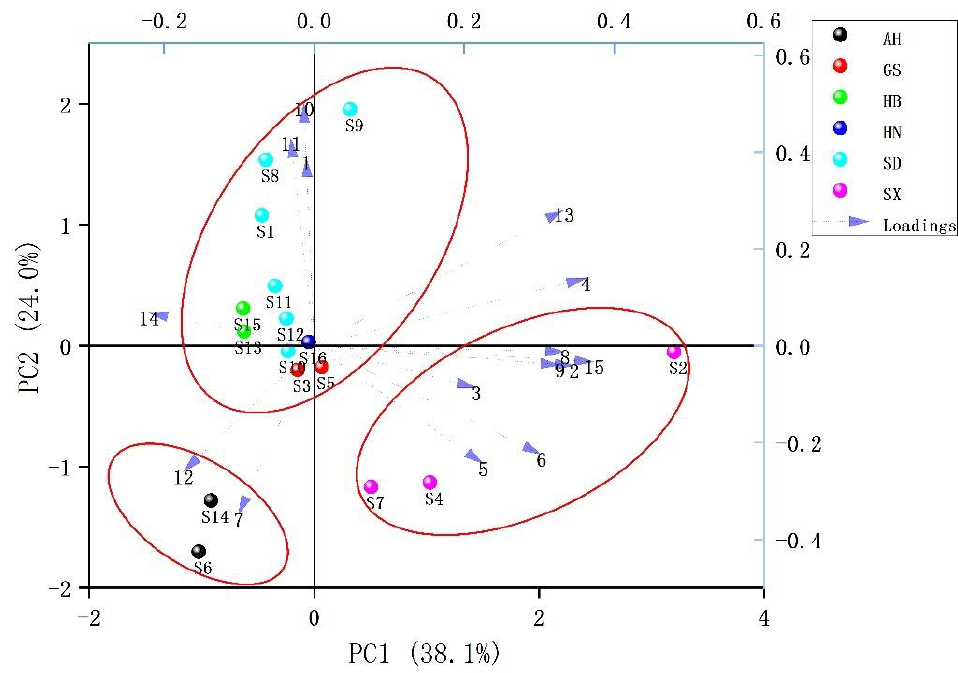
Figure 5. Principal component analysis biplot of Echinacea purpurea (L.) Moench.